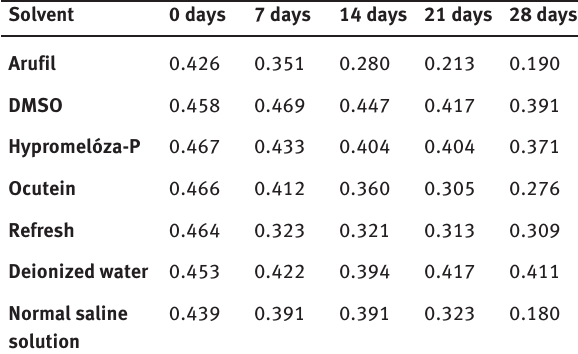
Table 2: Absorbance of 25 μM fisetin main peak in the eye drops (Arufil, Refresh, Ocutein, Hypromelóza-P), dimethylsulphoxide (DMSO), deionized water and normal saline solution (NSS).